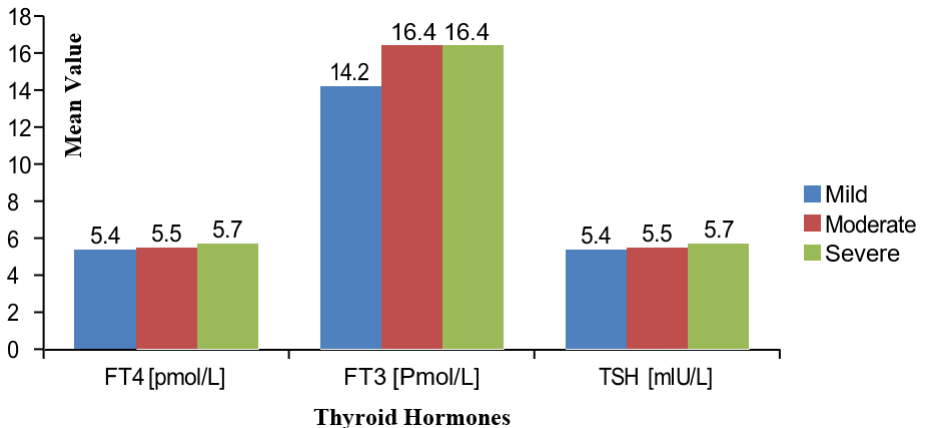
Figure 3: Comparison of Thyroid Hormones in Mild, Moderate and Severe D.F at TbS.